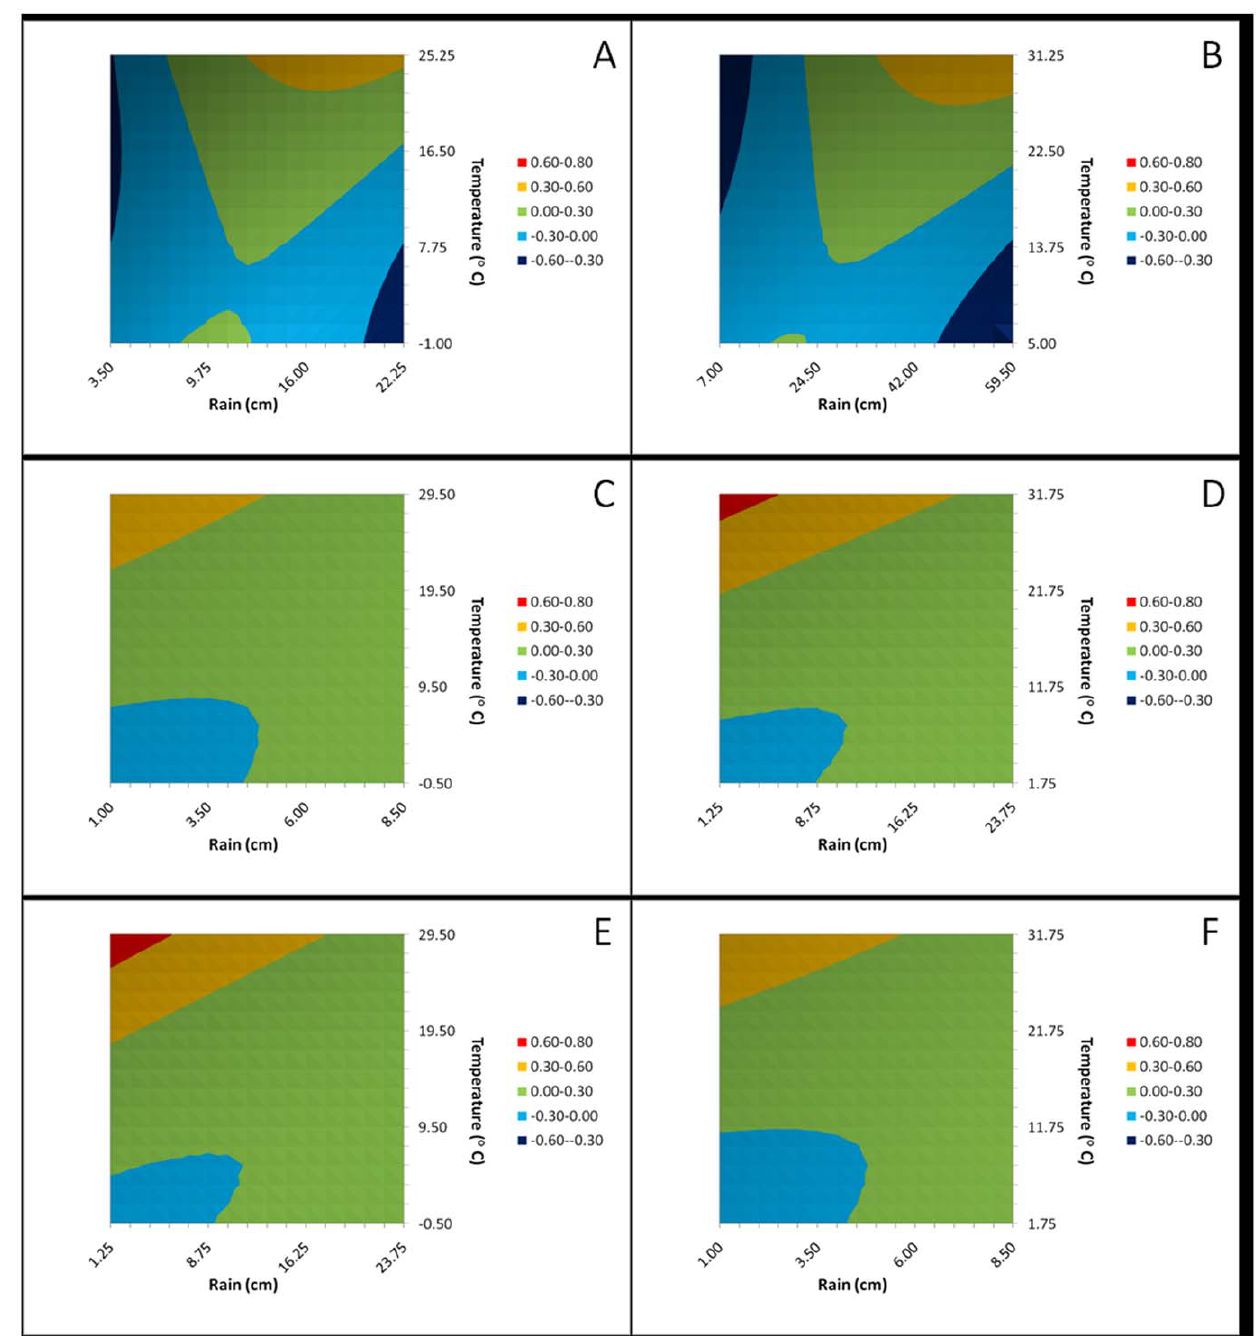
Figure 4. JE incidence as a function of climate variables. The response is the negative reciprocal of JE incidence. A) Annual climate model, B) June–July–August model, C) April climate model, D) May climate model, E) May temperature/April precipitation climate model and, F) April temperature/May precipitation climate model.